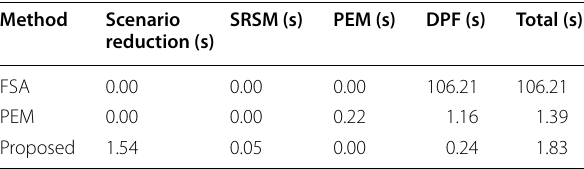
Table 7 T ime consumption of the algorithms Method